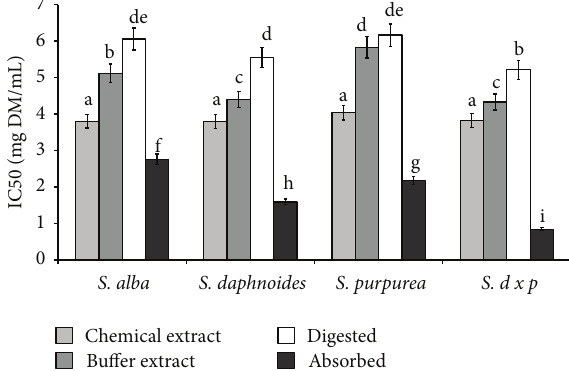
Figure 4: Effect of extraction system on reducing power of phy- tochemicals from bark of different Salix genotype. Bars (means) followed by the different letters differ significantly (Tukey-test, 𝑃 < 0.05